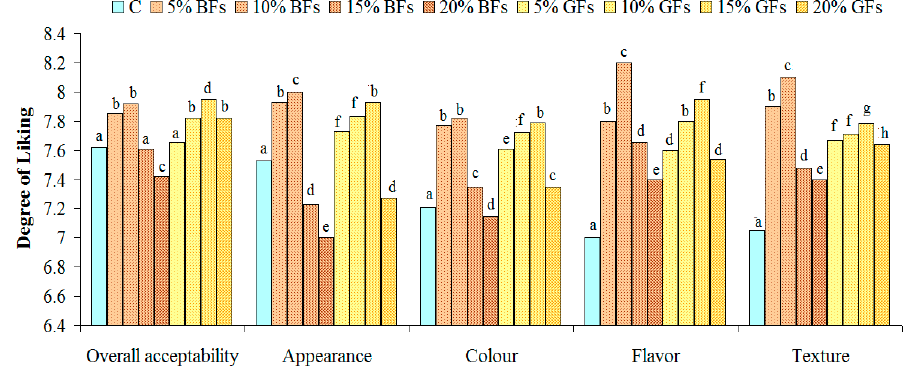
Figure 7. E ff ect of brown flaxseed (BFs) and golden flaxseed (GFs) at di ff erent addition levels: 0% (C), 5%, 10%, 15% and 20% on the sensory attributes of bread from a WF of a good quality for bread-making. Means with di ff erent superscripts indicate significant di ff erence among treatments ( p < 0.05).